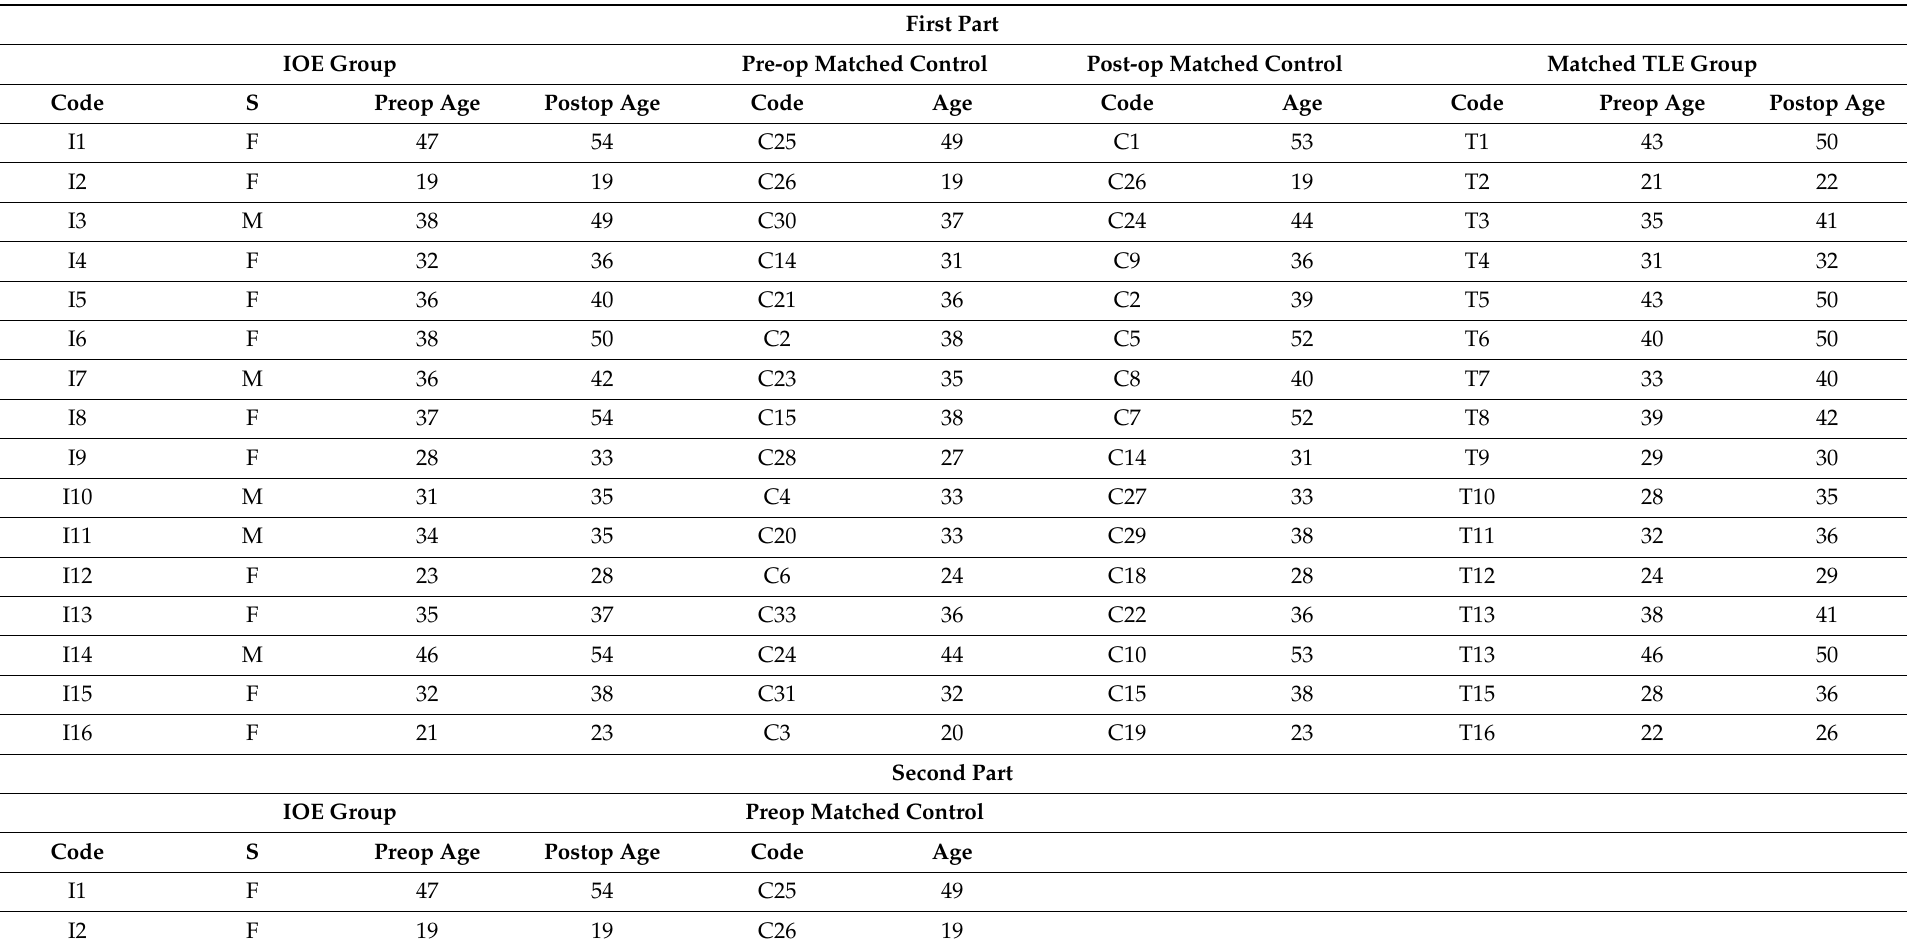
Table A2. Age-, sex matched controls for patients’ groups at pre- and post-operative